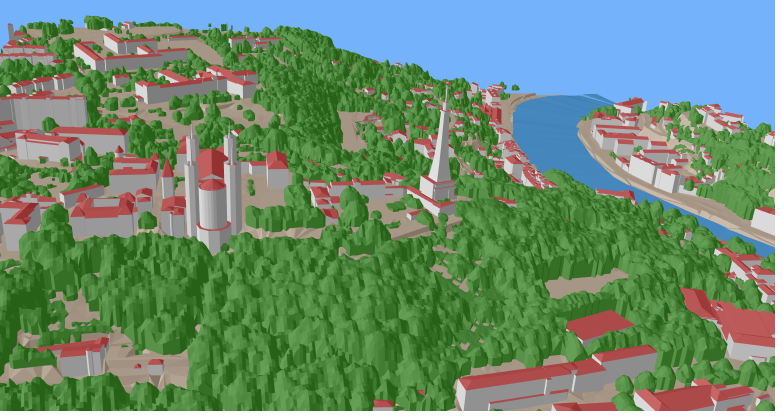
Figure 11. Three-dimensional visualization of a tile (1 × 1 km) of the CityGML model of